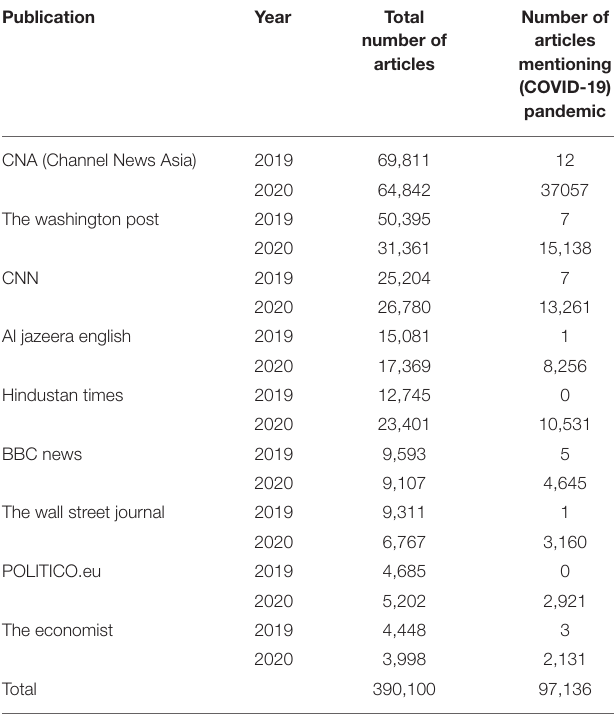
TABLE 1 | Data sources and number of extracted news